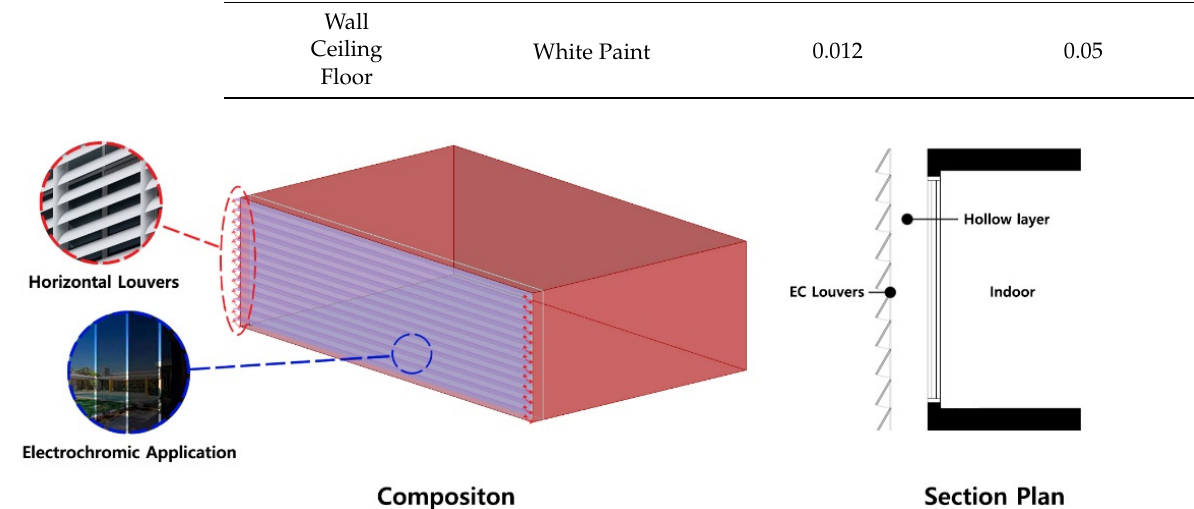
Figure 3. Proposed EC louver.